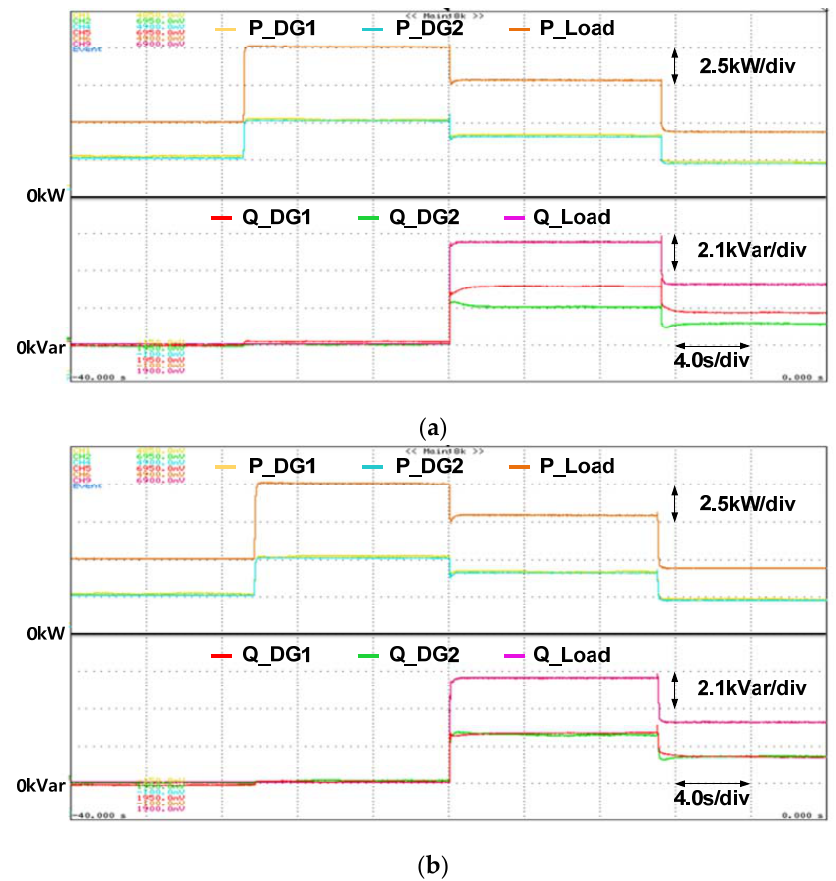
Figure 18. Configuration of hardware test set ‐ up.